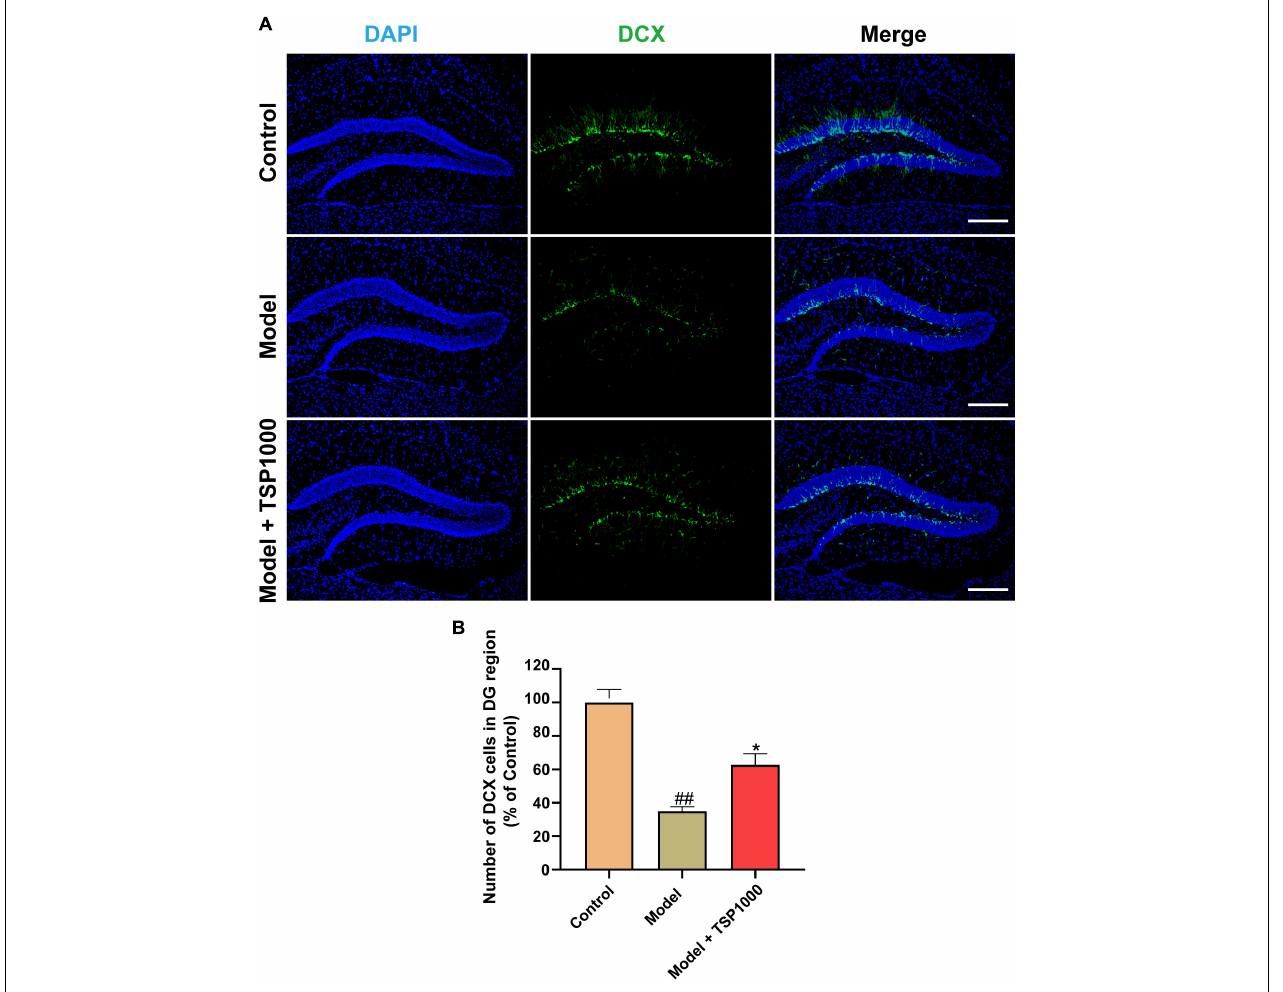
FIGURE 6 | The effects of TSP on neurogenesis in the hippocampus. (A) The representative staining of DCX immunofluorescence images in the hippocampus (Scale bar: 100 µ m). (B) The number of DCX positive cells was calculated. All data were expressed as mean ± SEM ( n = 3). ## P < 0.01 vs. Control group; * P < 0.05 vs. Model